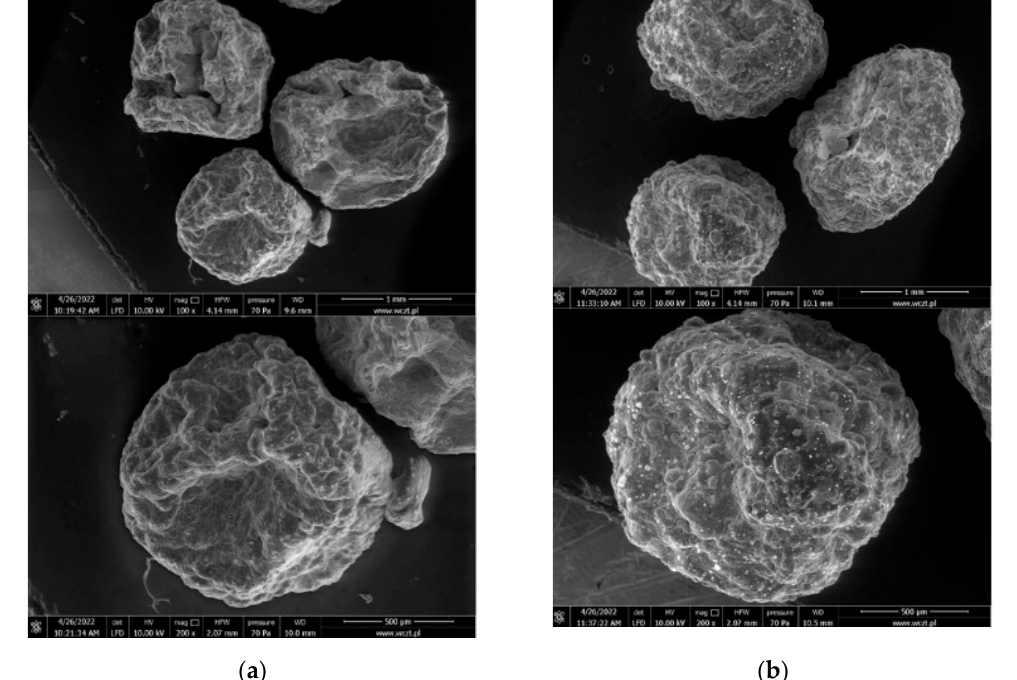
Figure 6. Scanning electron micrographs of alginate capsules with gemini surfactants. ( a ) Al@12-O-12; ( b ) Al@12-O-12+BaSO 4 .